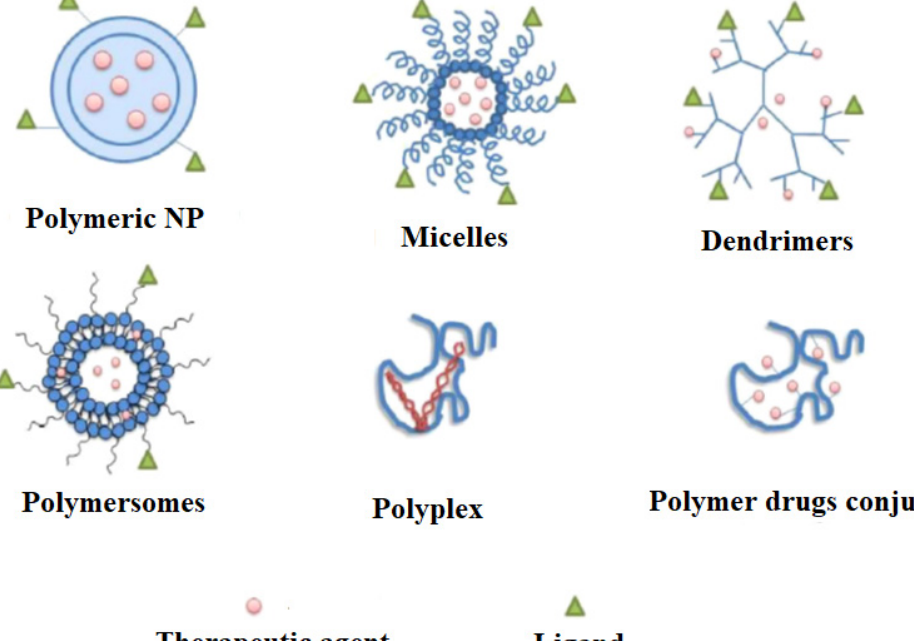
Figure 2. The different types of polymeric NPs as carriers for drugs delivery. Figure 2. The di ff erent types of polymeric NPs as carriers for drugs